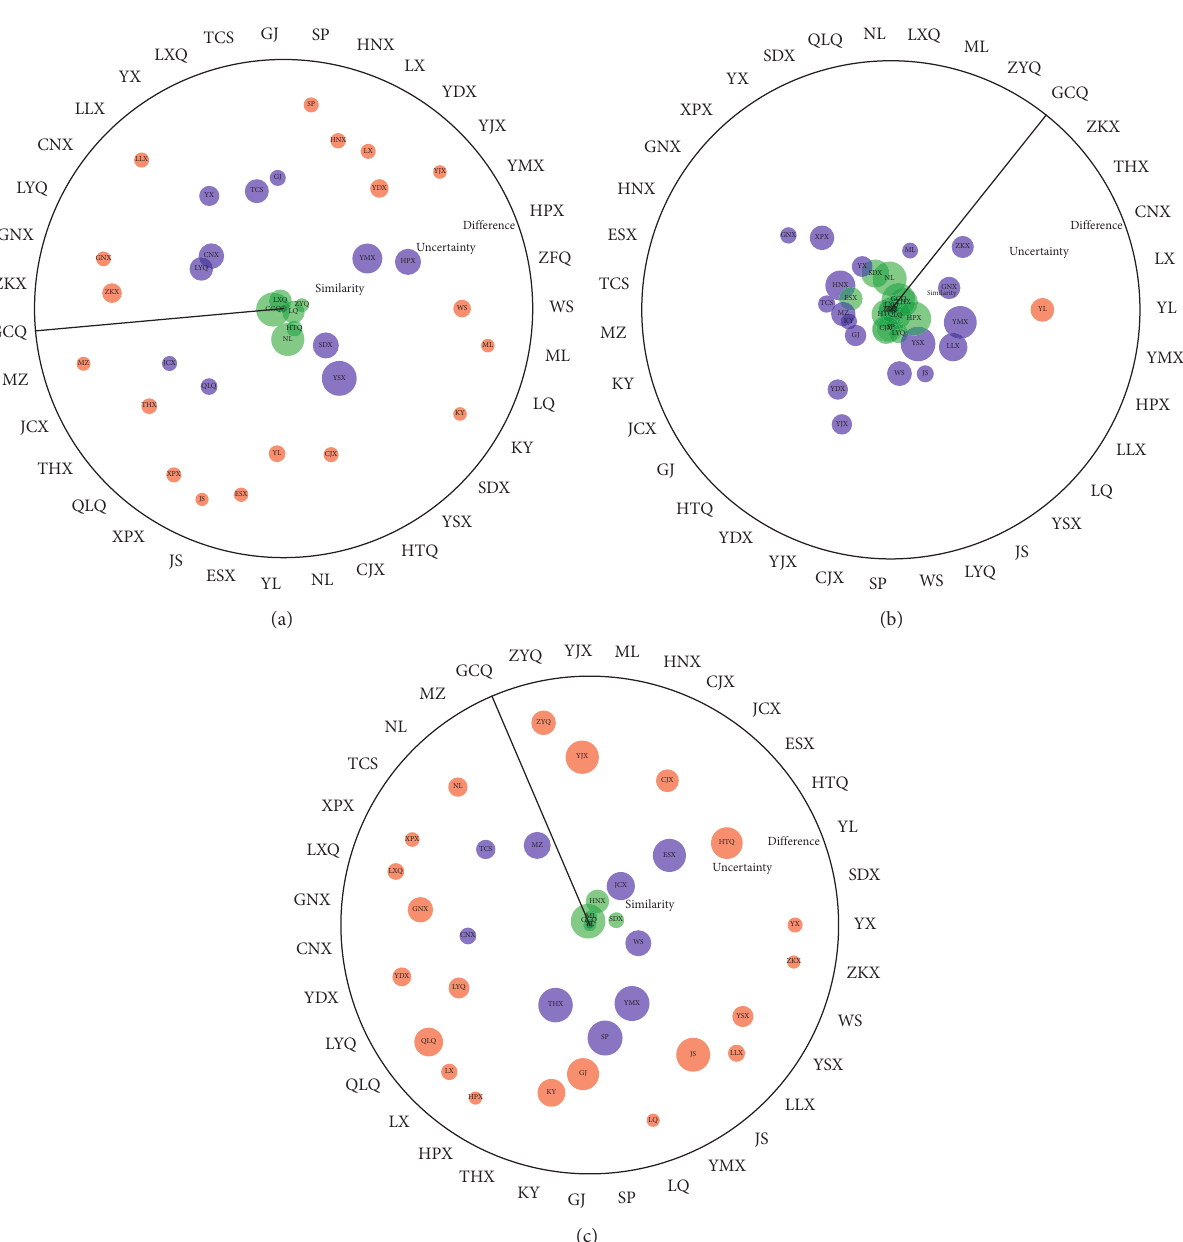
Figure 7: The results of climate, altitude, and chemical compositions with comparison of other locations, using GCQ as an example. (a), (b), (c) The comparative results of climate, altitude, and chemical compositions in GCQ and 34 other locations. In the plot, the value in the most central and extreme edge of the circle is 1 and 0, respectively. The closer it is to the center of the circle, the more similar it is to the characteristics of the samples in GCQ. If GCQ is closer to the center of the circle, it means that GCQ has high